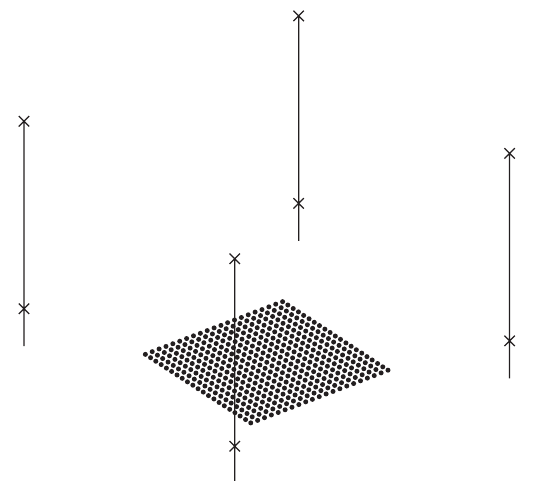
Figure 2: The setup of the antenna array system. The dots denote the antenna elements and the “x” are the probes.